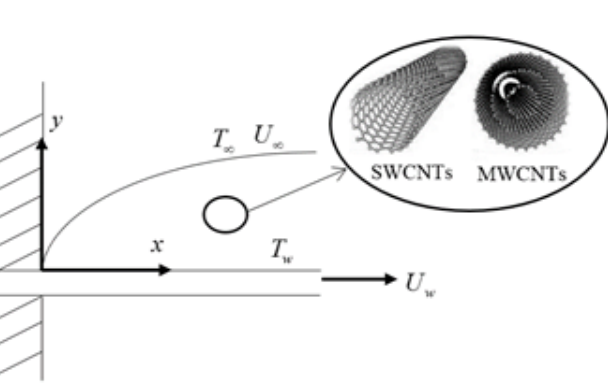
Figure 1. Schematic diagram of the problem.